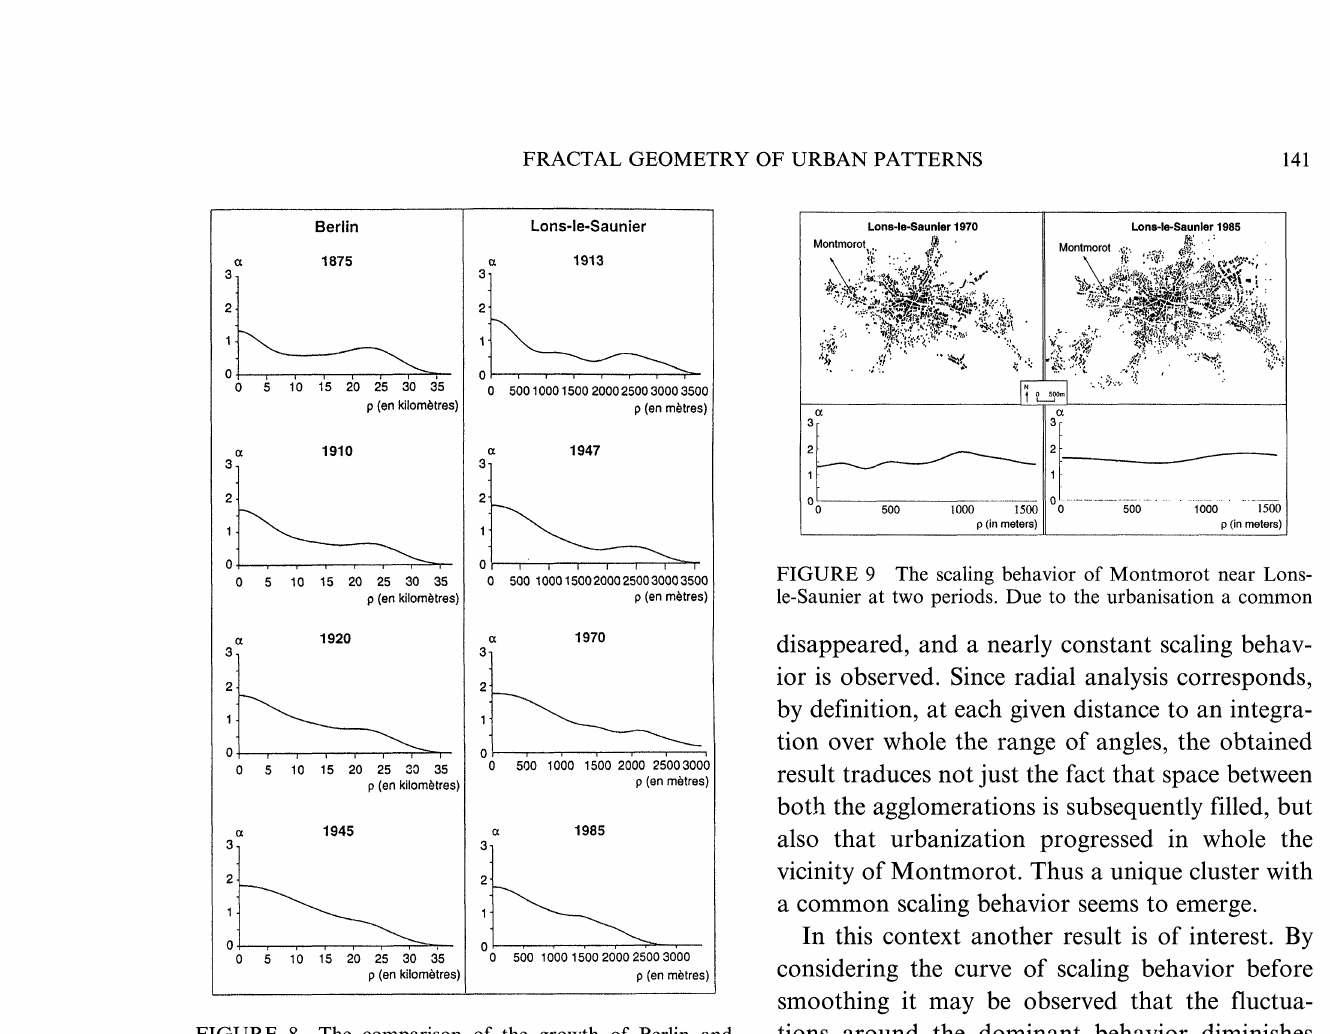
FIGURE 8 The comparison of the growth of Berlin and Lyons by means of the smoothed curves of scaling behavior. The same type of transformation of the shape of the curves occur.